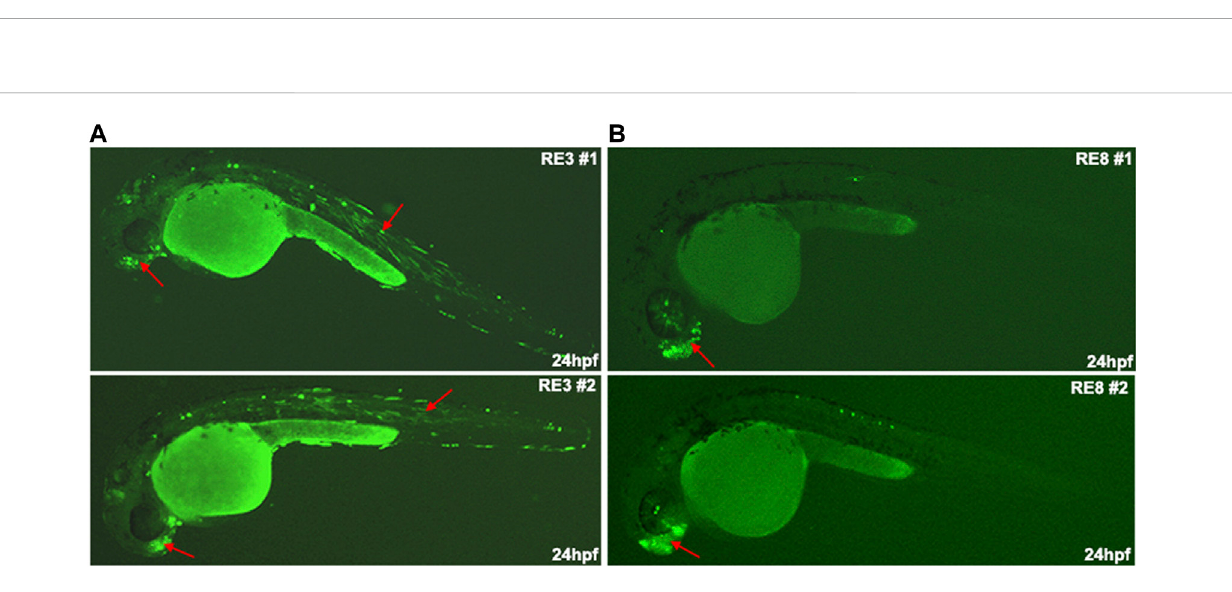
FIGURE 5 The in vivo enhancer activity of regulatory elements (REs) from the non-active enhancer set. (A) RE3 drove GFP expression in speci fi c neurons in the forebrainandsomiticmusclesat24 hpfzebra fi shembryos. (B) RE8droveGFPexpressionintheforebrainat24 hpfzebra fi shembryos(redarrowsinbiological